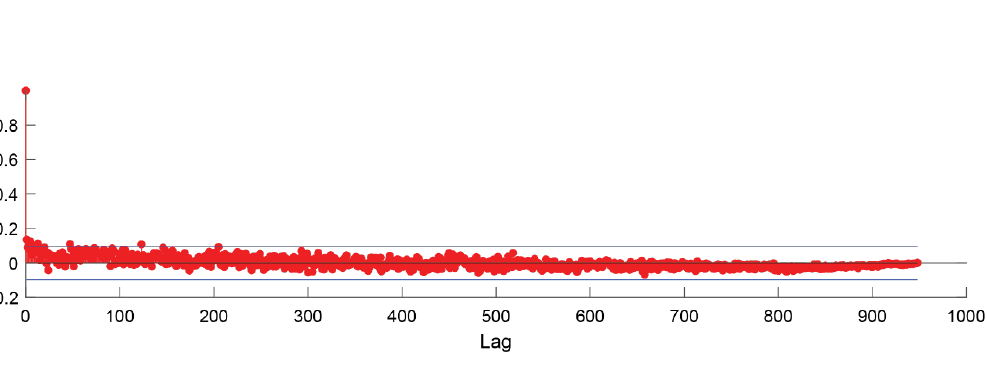
Figure A1. Sample autocorrelation plot for the pentad rainfall-triggered landslides. The 99% confidence interval is shown by the blue horizontal lines.